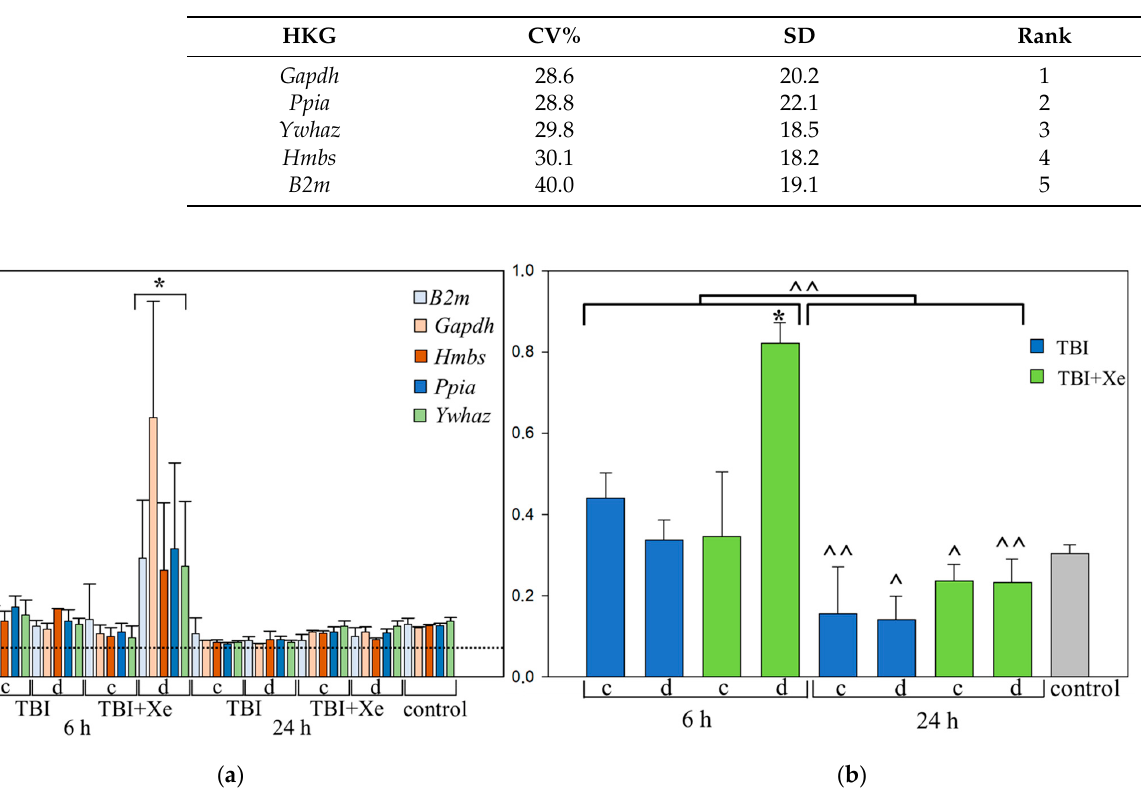
Figure 1. Housekeeping gene variations. ( a ) Mean of changes in the expression of HKGs in each group. ( b ) Coefficient of variation of HKG expression in brain tissue after TBI. * p <0.05 to each group; 24 h vs. 6 h: ^ p <0.05, ^^ p <0.0001. One-way ANOVA, Holm–Sidak method; c—contralateral area, d—damaged area.